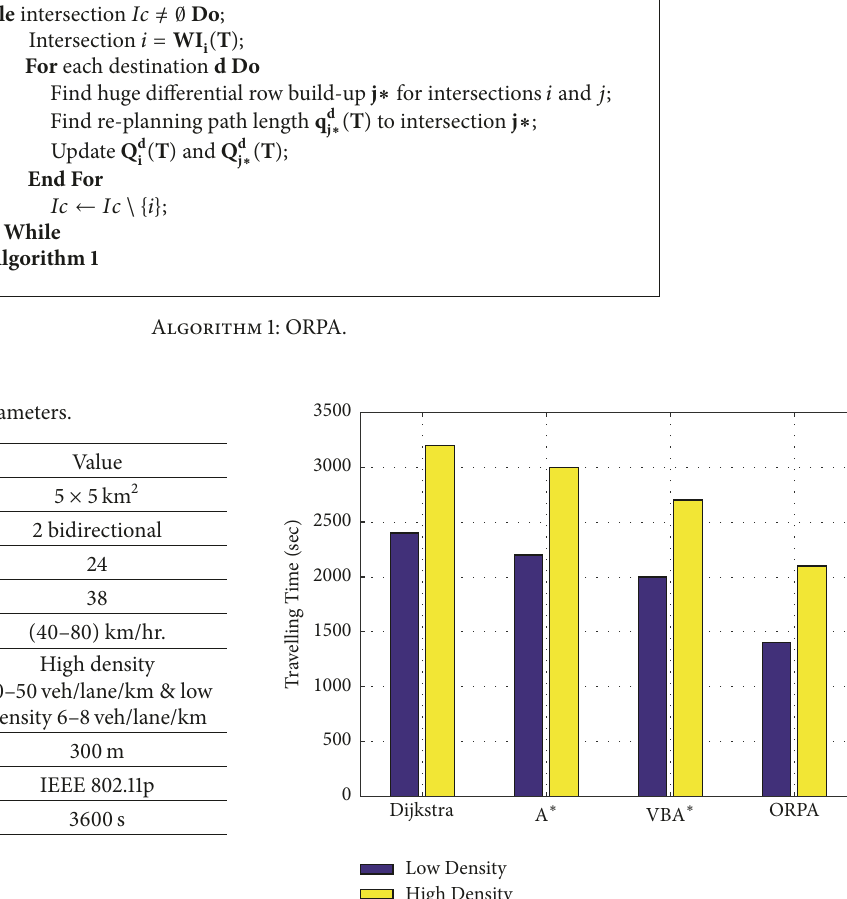
speed of ORPA, Dijkstra, A ∗ , and VBA ∗ reaches 45, 23, 26, and 32 km/hr, respectively. Hence, the average ambulance speed of ORPA is 48.8%, 42.2%, and 28.8% higher than that of Dijkstra, A ∗ , and VBA ∗ , respectively, whereas in high- density the average ambulance speed of ORPA, Dijkstra, A ∗ , and VBA ∗ reaches 30, 12, 17, and 20 km/hr,